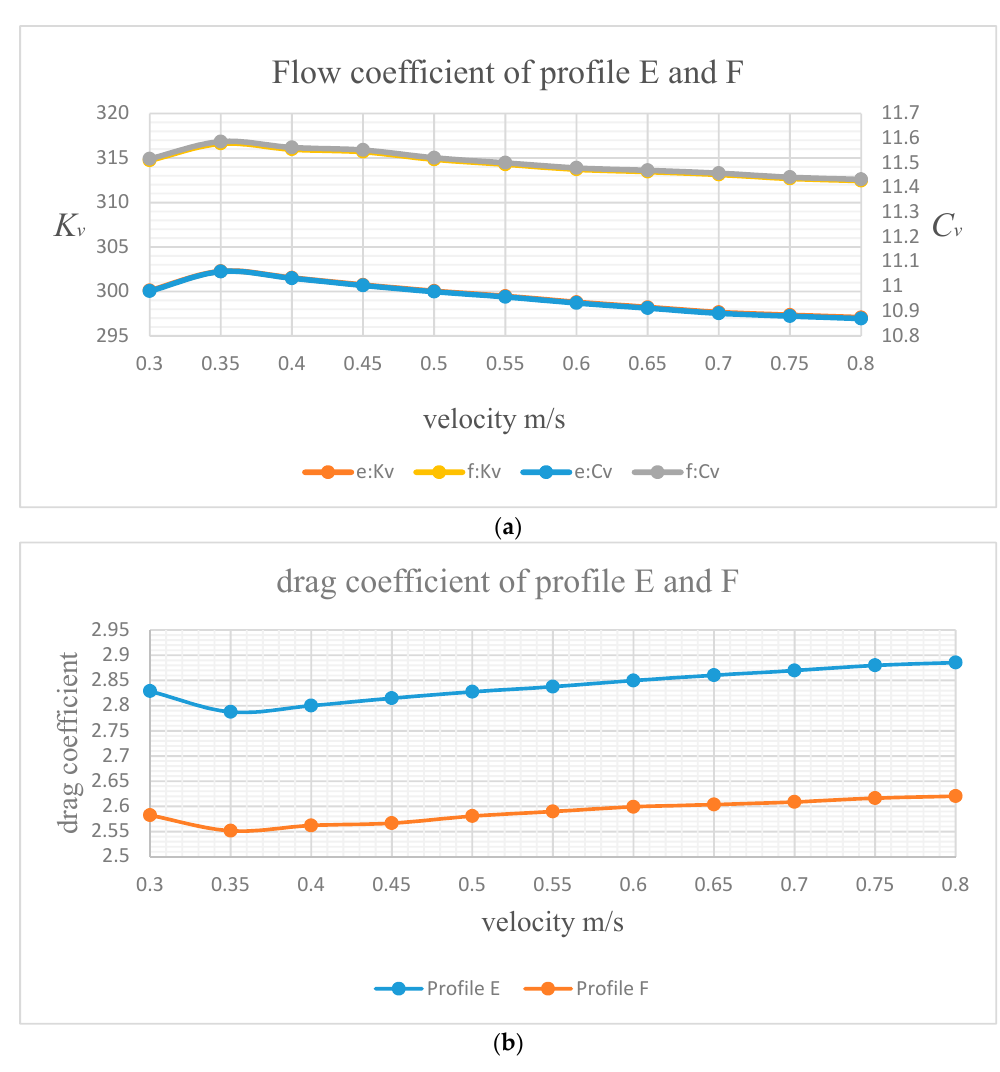
Figure 18. Comparison on flow characteristics ( a ) and drag characteristics ( b ) between profile E and the optimized profile F.